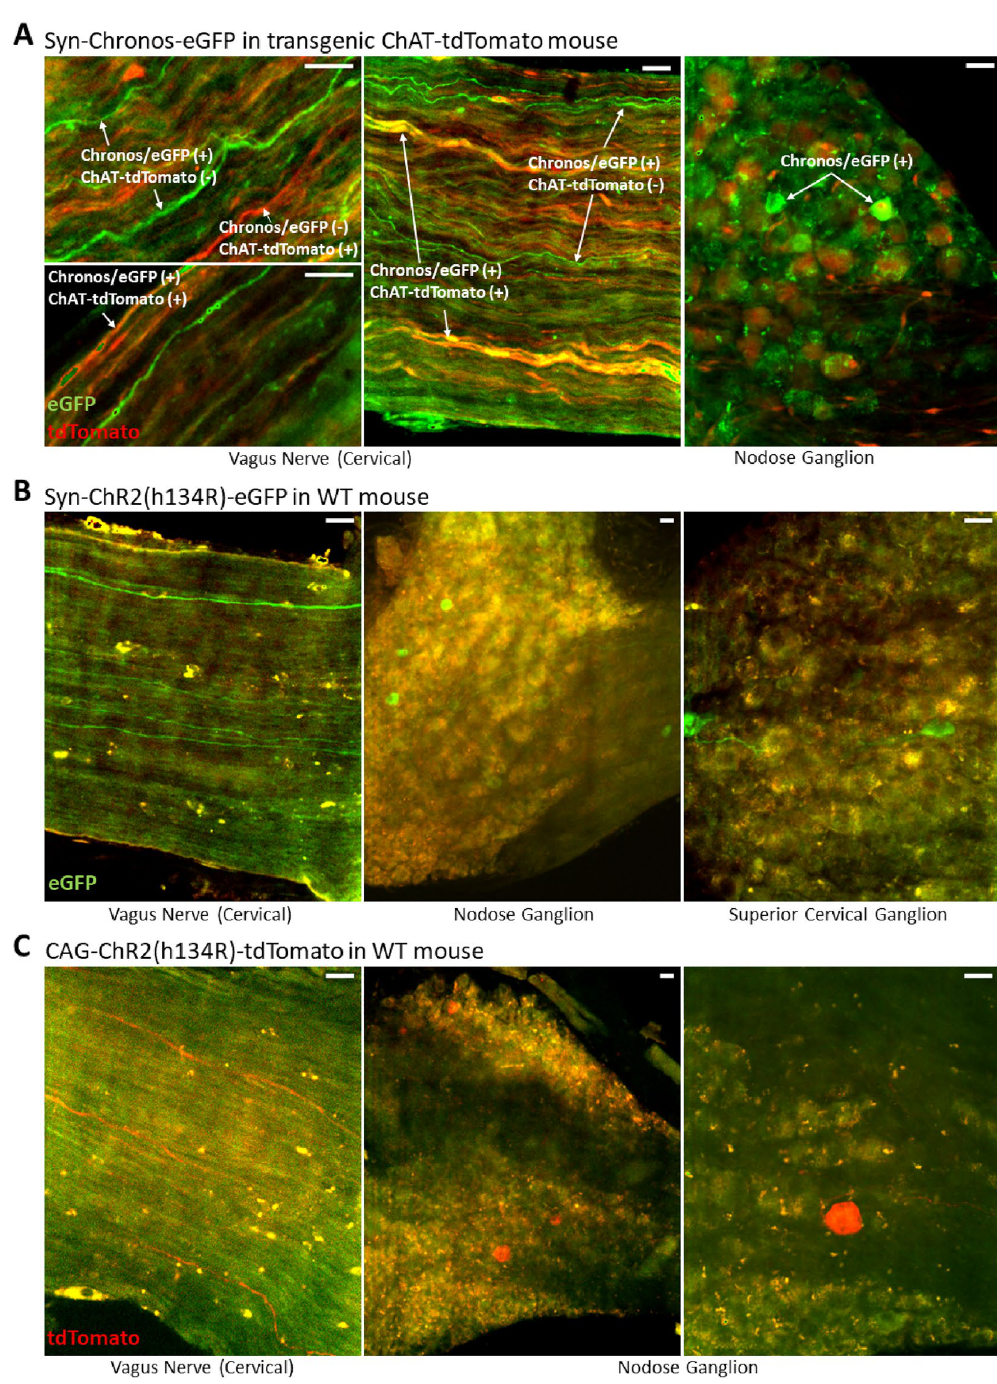
Figure 2. Retrograde labeling in vagus nerve and nodose ganglia (NG) and superior cervical ganglia (SCG) with heart-injected rAAV2-retro constructs. Three constructs were injected: ( A ) Syn-Chronos-eGFP, injected in ChAT-tdTomato transgenic mice. eGFP expression (green) was observed in ChAT-positive (tdTomato, red) and ChAT-negative axons throughout the vagus nerve, and in neurons of the NG. ( B ) Syn-ChR2(h134R)-eGFP (green) injected in wild-type mice. eGFP expression is found in axons of the cervical vagus and NG neurons, as well as in neurons of the SCG. ( C ) CAG-ChR2(h134R)-tdTomato. tdTomato reporter expression (red) is observed in cervical vagus nerve and NG, in a similar expression pattern. All scale bars are 30 µm. (Images were rendered in Fiji software: https ://image